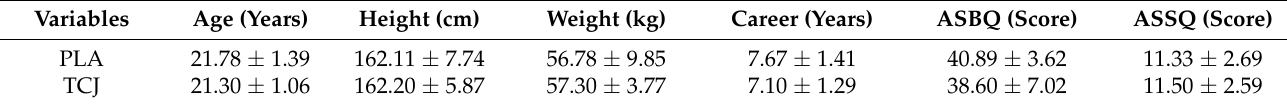
Table 1. Physical characteristics of the